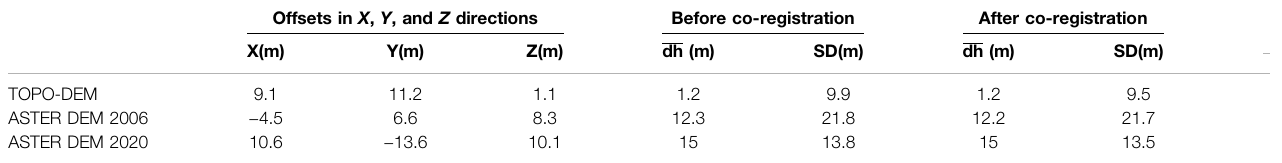
TABLE 2 | Offsets in X , Y , and Z directions of the DEM dataset and the uncertainty in DEMs before and after co-registration. Offsets in X , Y , and Z